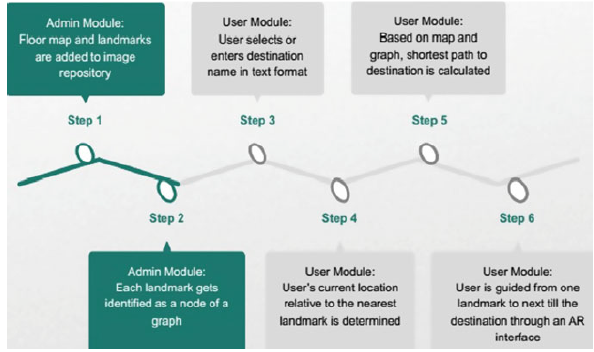
Figure 1. Implementing augmented indoor navigation system using direction